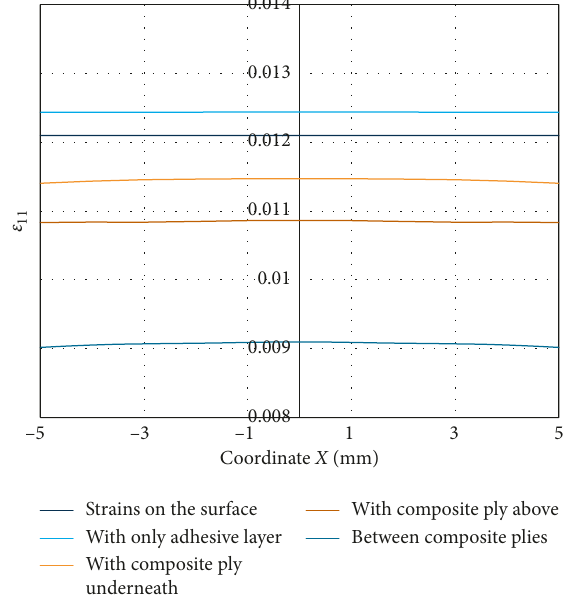
Figure 4: Comparison of strain values ε 11 in the Bragg grating zone, obtained with different configurations of fiber surroundings.